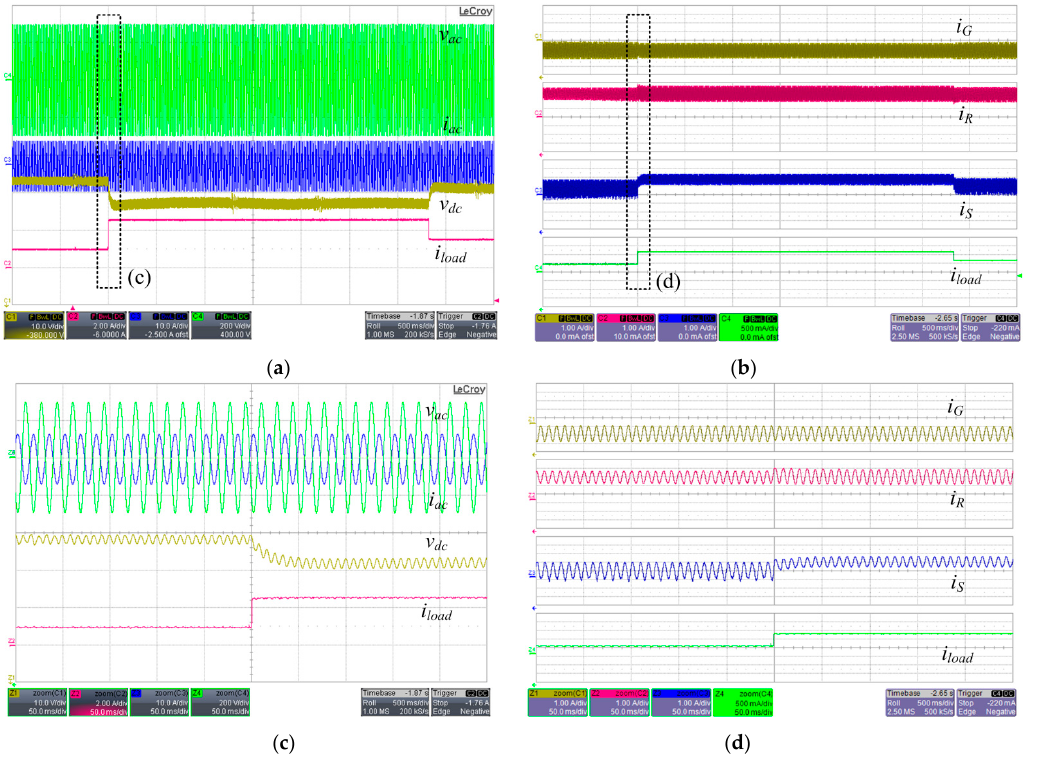
Figure 12. Experimental waveforms of load step change on State 211. ( a ) Bus voltage and current; ( b ) output current; ( c ) zoomed-in waveform of ( a ); and ( d ) zoomed-in waveform of ( b ).